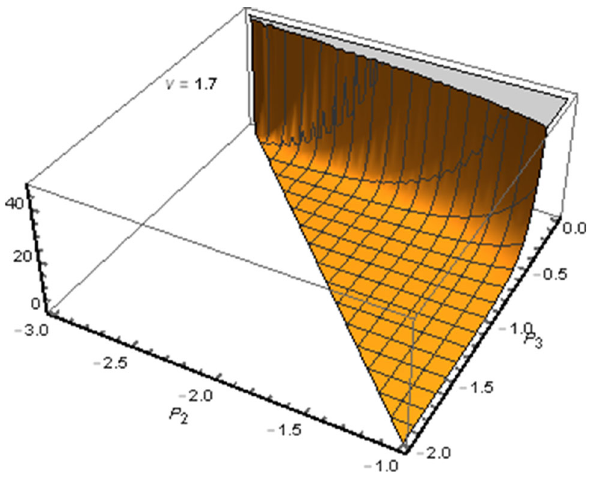
Fig. 17 This diagram expresses the behavior of shape function pre- sented in Eq. (32) for the case ν = 1 .